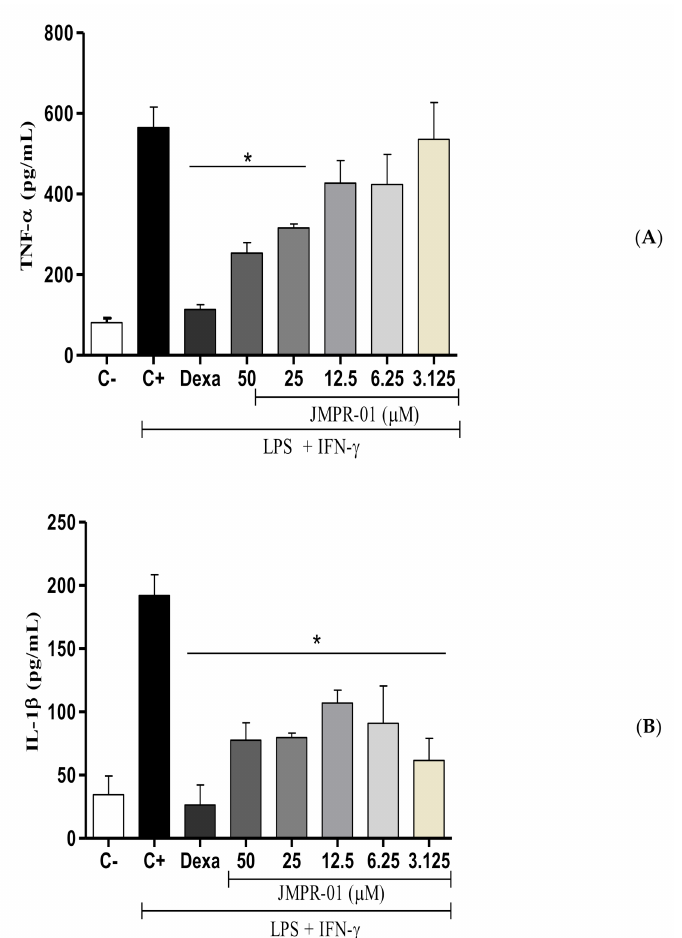
Figure 3. Inhibition of cytokines TNF- α ( A ) and IL-1 β ( B ) in activated J774 macrophage cells treated with JMPR-01 (3.125–50 µ M) by enzyme-linked immunosorbent assay (ELISA). Data representes mean standard error of the mean ± SEMs; n = 4 for TNF- α and n = 6 IL-1 β determinations per group. * Significantly different from the vehicle treated cultures stimulated with LPS + IFN- γ ( p < 0.05). ANOVA followed by Tukey ´ s multiple comparison